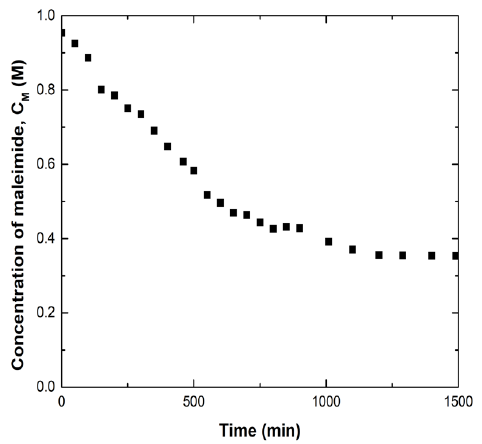
Figure 5. Maleimide concentration during reaction of furan and maleimide in 2.3 M FGE 0.26 M maleimide groups from MMI2 in PA at 25 °C.